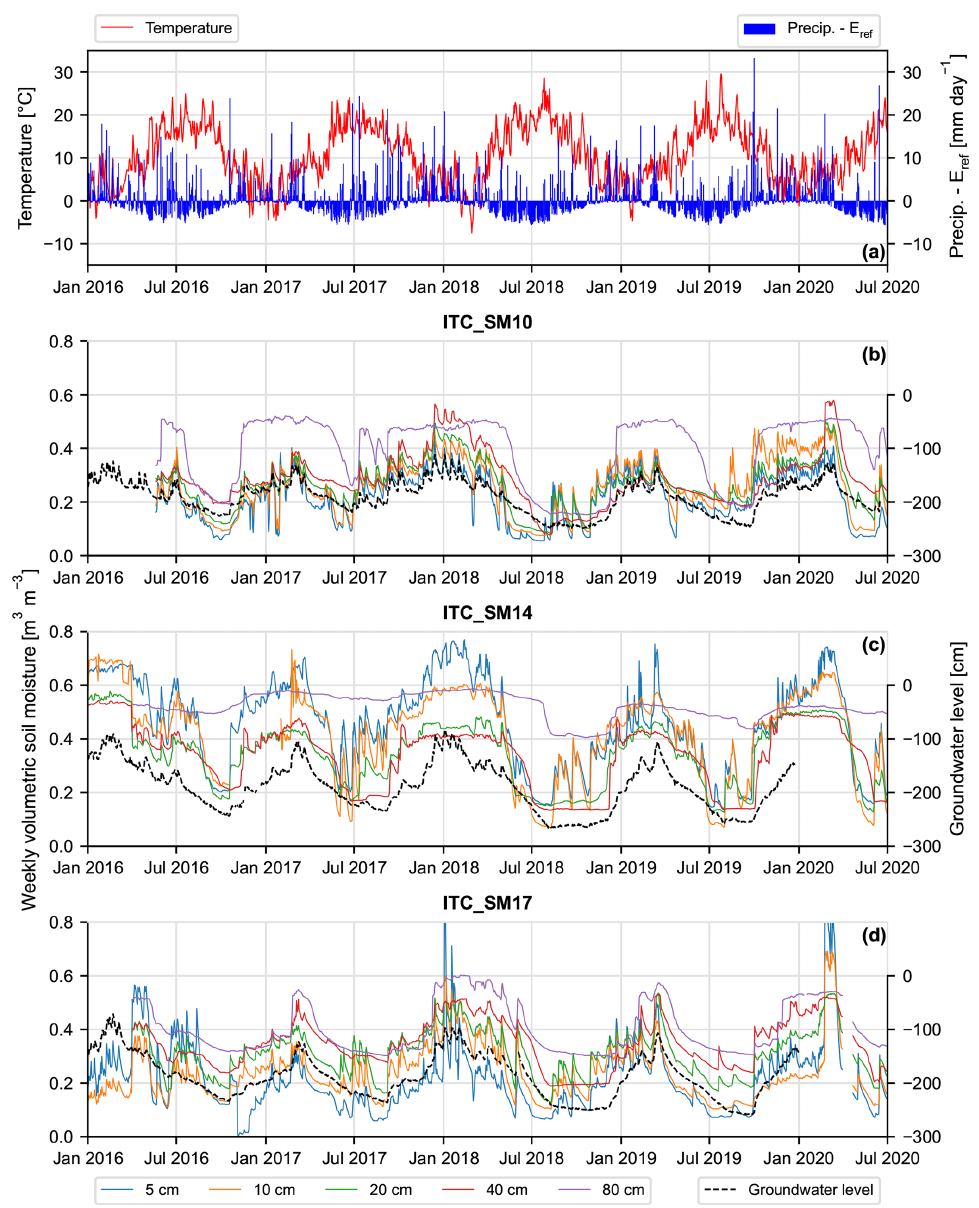
Figure 10. (a) Daily rainfall and daily air temperature as averages of the three KNMI automated weather stations. (b–d) Profile of soil moisture measured at (b) ITC_SM10, (c) ITC_SM14, and (d) ITC_SM17, and groundwater level measured in the nearest well available in DINOLoket (see Table